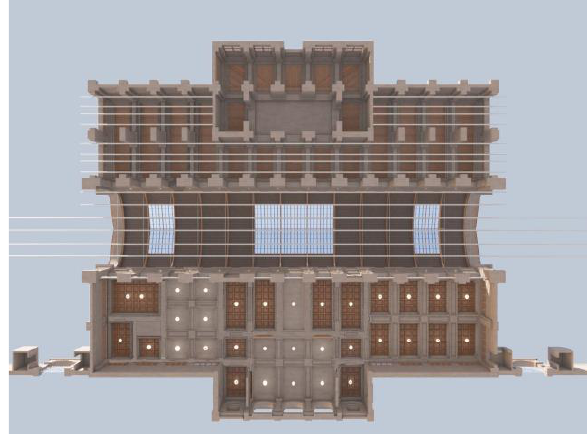
Figure 8. Perspective sections extracted and processed from the digital 3D model